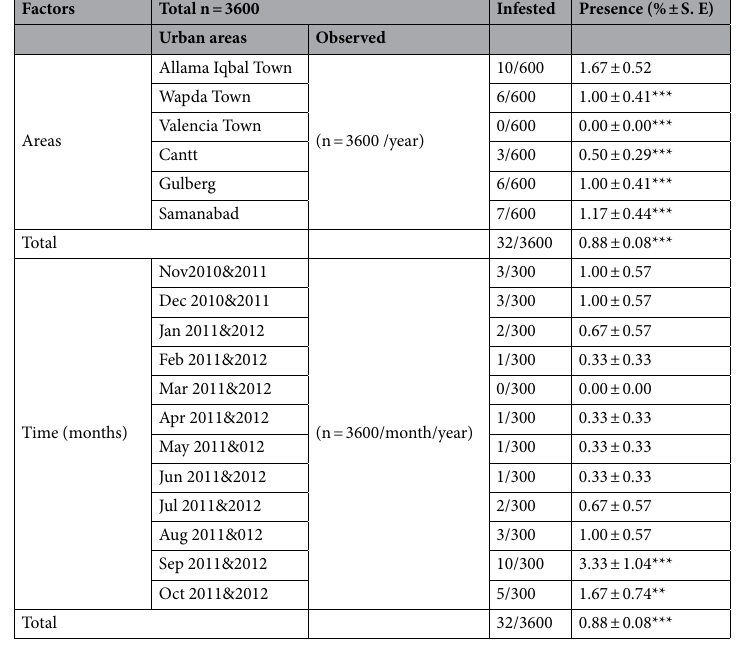
Table 1. Overall area wise, monthwise and seasonwise presence (%) of Ascaris lumbricoides ’s eggs in soil samples of urban areas of Lahore, Punjab, Pakistan from November 2010—October 2012. *P < .05, **P < .01, ***P < .001